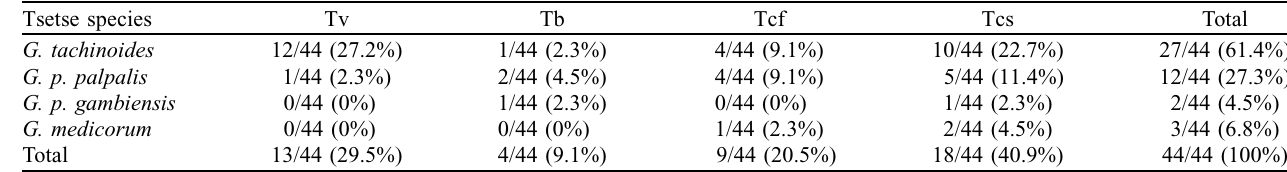
Table 2. Trypanosome species and subgroup frequency by tsetse species. Tsetse